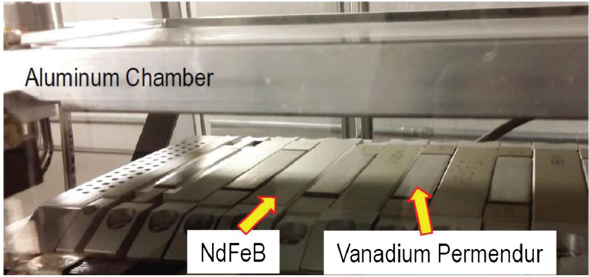
FIG. 2. Damping wiggler at open position and the aluminum vacuum chamber (side view).